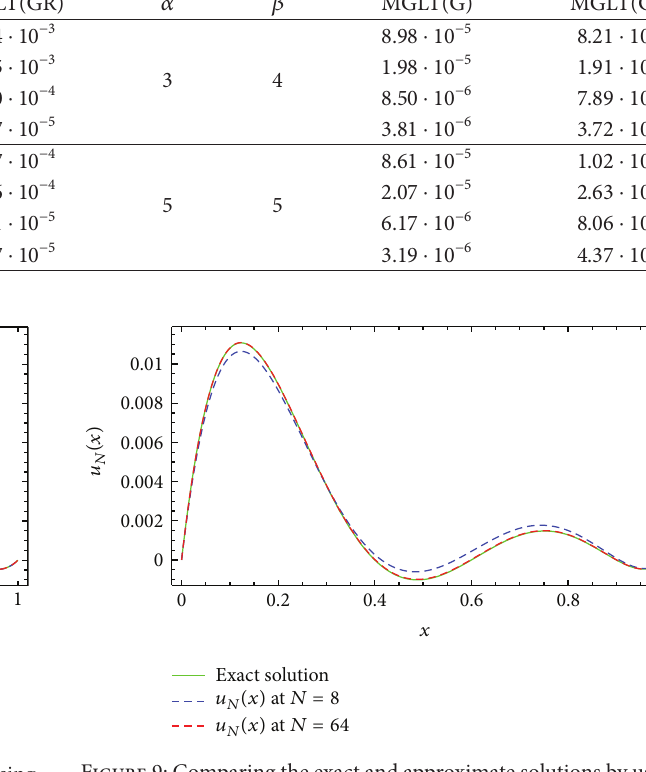
Figure 8: Comparing the exact and approximate solutions by using MGLT (Gauss) at 𝑁 = 8, 64 , with 𝛼 = 2 and 𝛽 = 4 .